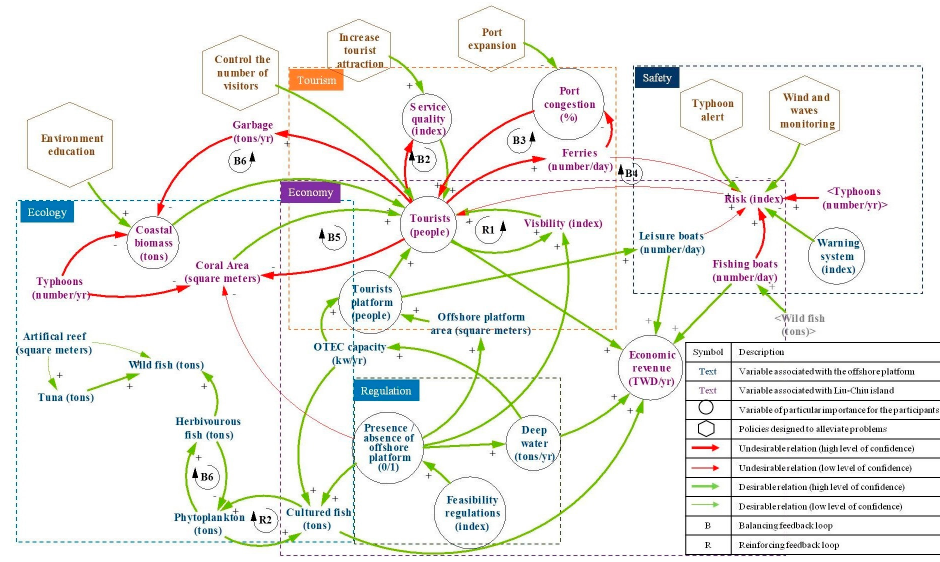
Figure 4. Causal-loop diagram.